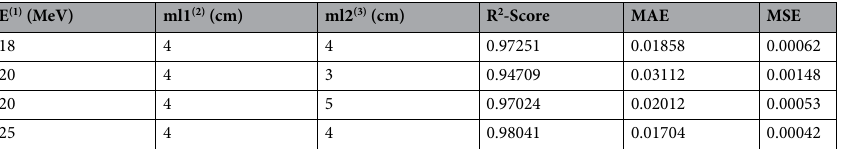
Table 2. Properties of the four sample datasets as well as the performance of the trained MLP model tested with them. (1) Input electron energy of Linac. (2) Thickness of the first moderator (BeD 2 ). (3) Thickness of the second moderator